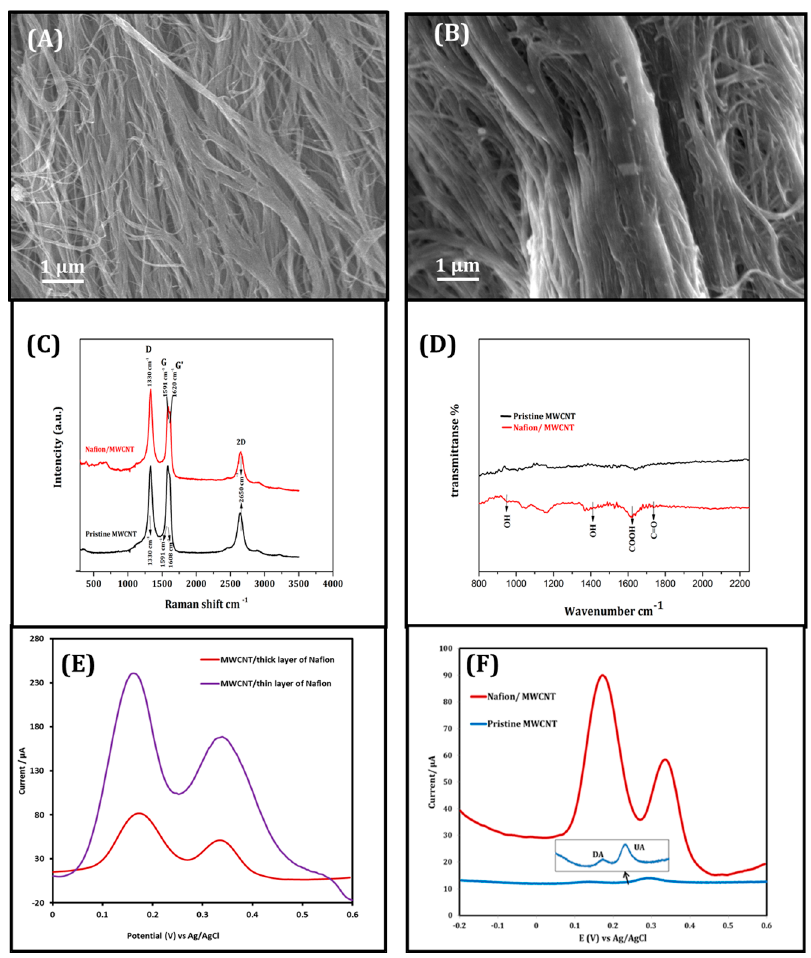
Figure 2. ( A,B ) High resolution SEM images of MWNT bundles without/ with Nafion coating respectively; ( C ) Raman spectra of pristine and Nafion-coated MWNT yarn; ( D ) FTIR spectra of uncoated and Nafion-coated MWNT yarn; ( E ) DPV of different thickness of Nafion layer (10 µM DA with 200 µM UA & AA ); ( F ) DPV of MWNT without and with Nafion coating (10 µM DA + 200 µM AA & UA each).